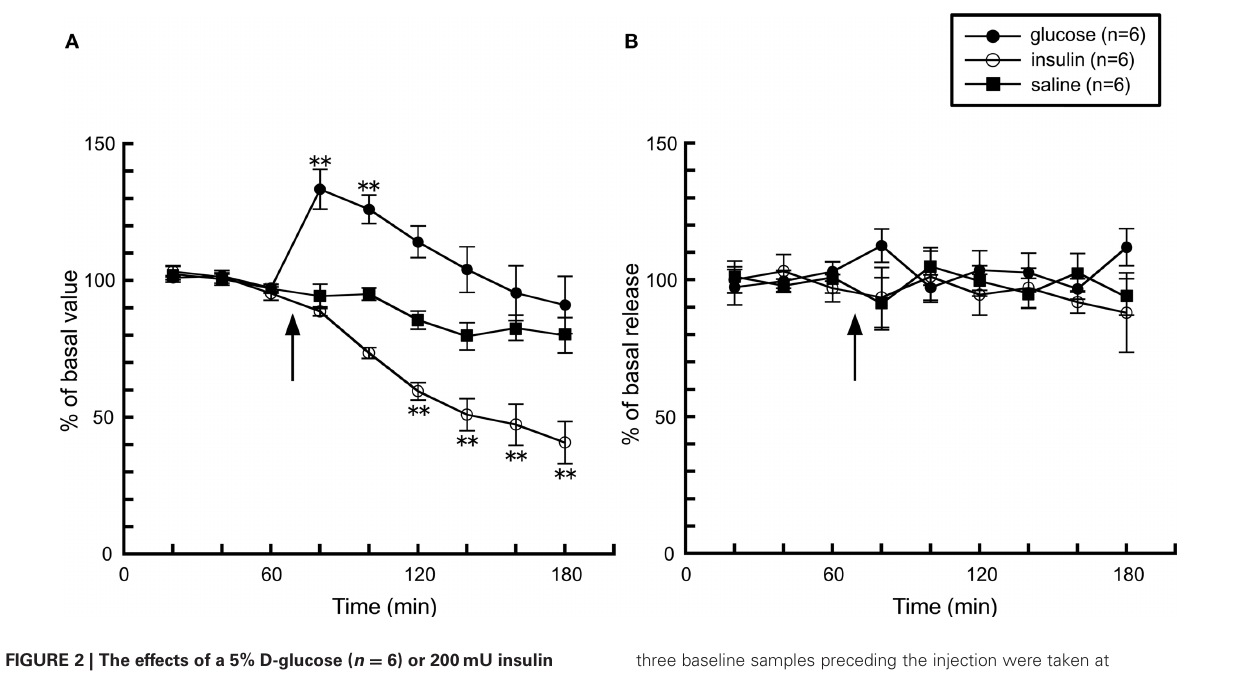
three baseline samples preceding the injection were taken at 100%. Values are presented as percentages of the mean basal values ± SEM ∗∗ p < 0 . 01 compared with the basal values of each group.